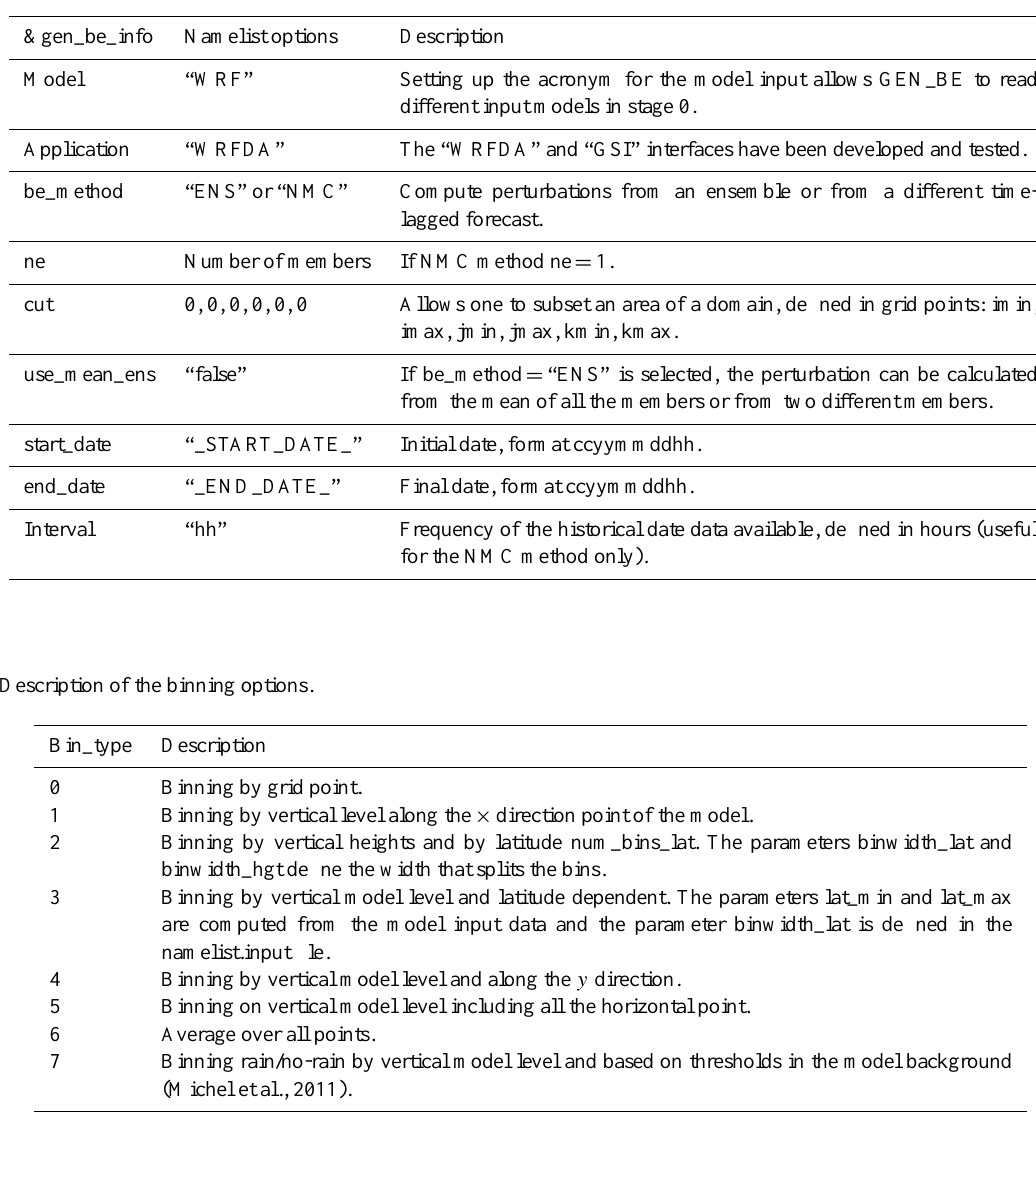
Table B1. General information defining the experiment in the namelist input file (&gen_be_info part).